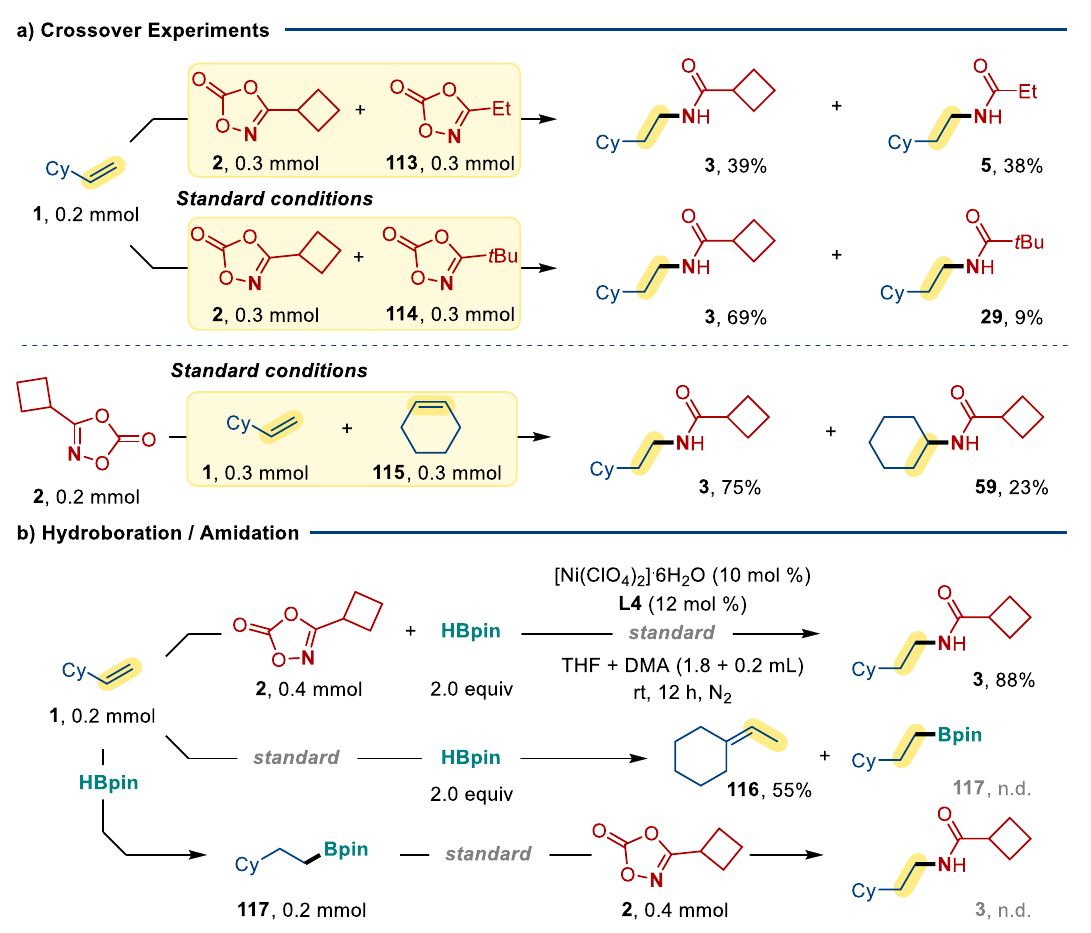
Fig. 5 Hydroamination/hydroamidation with common aminating or amidating reagents. Standard conditions : alkene (0.2 mmol), aminating (amidating) reagents (0.4 mmol), [Ni(ClO 4 ) 2 ] ∙ 6H 2 O (10 mol %), L4 (12 mol %), HBpin (2.0 equiv), THF + DMA (1.8 + 0.2 ml), in N 2 at room temperature for 12 h. All yields were presented as NMR yield.